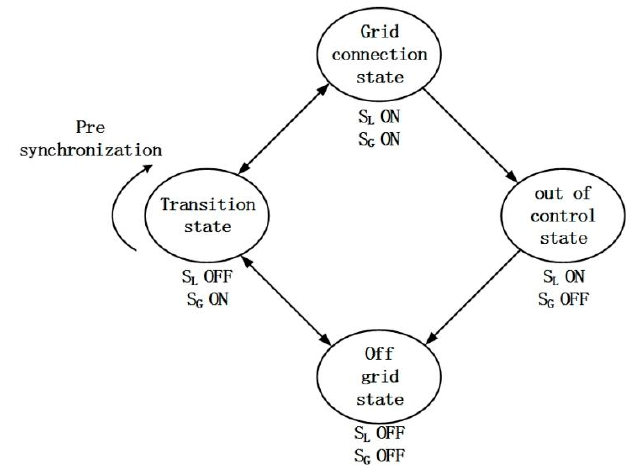
Figure 3. Four working states of microgrid.